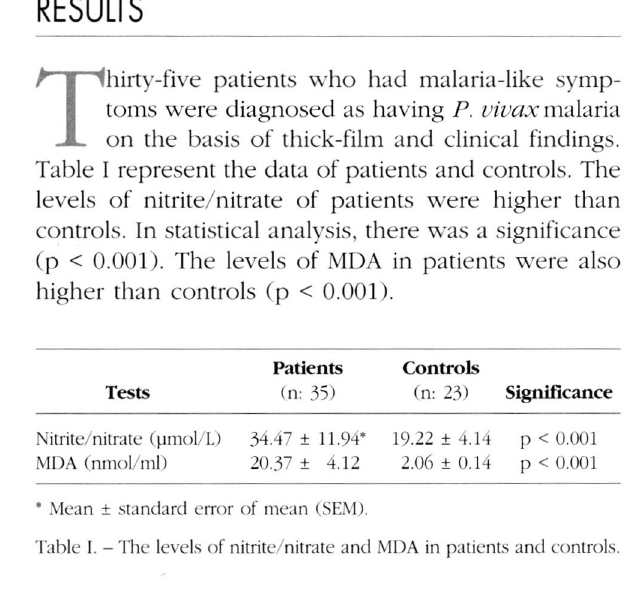
Table I. - The levels of nitrite 'nitrate and MDA in patients and